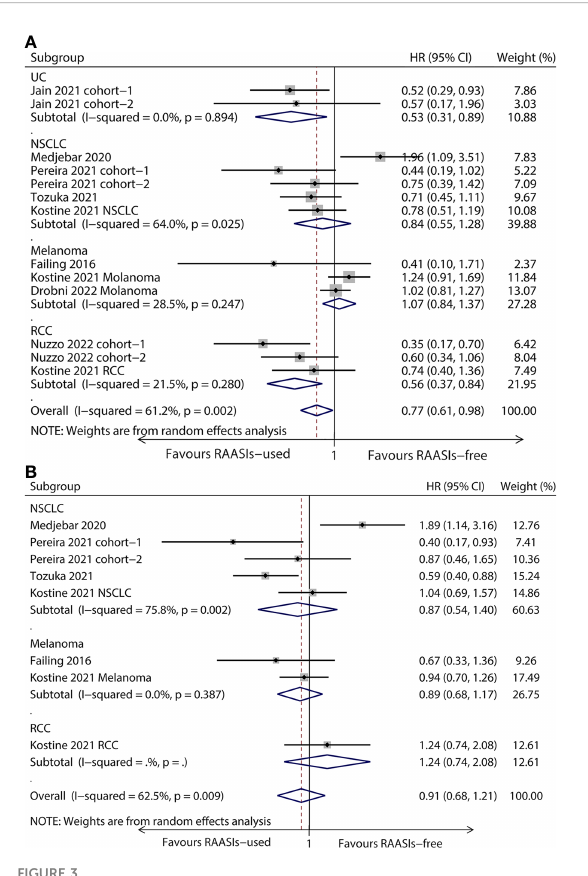
FIGURE 3 Forest plots of subgroup analysis by cancer type. Results for OS (A) and PFS (B) . OS, overall survival; PFS, progression-free survival; HR, hazard ratio; UC, urothelial carcinoma; NSCLC, non-small cell lung cancer; RCC, renal cell